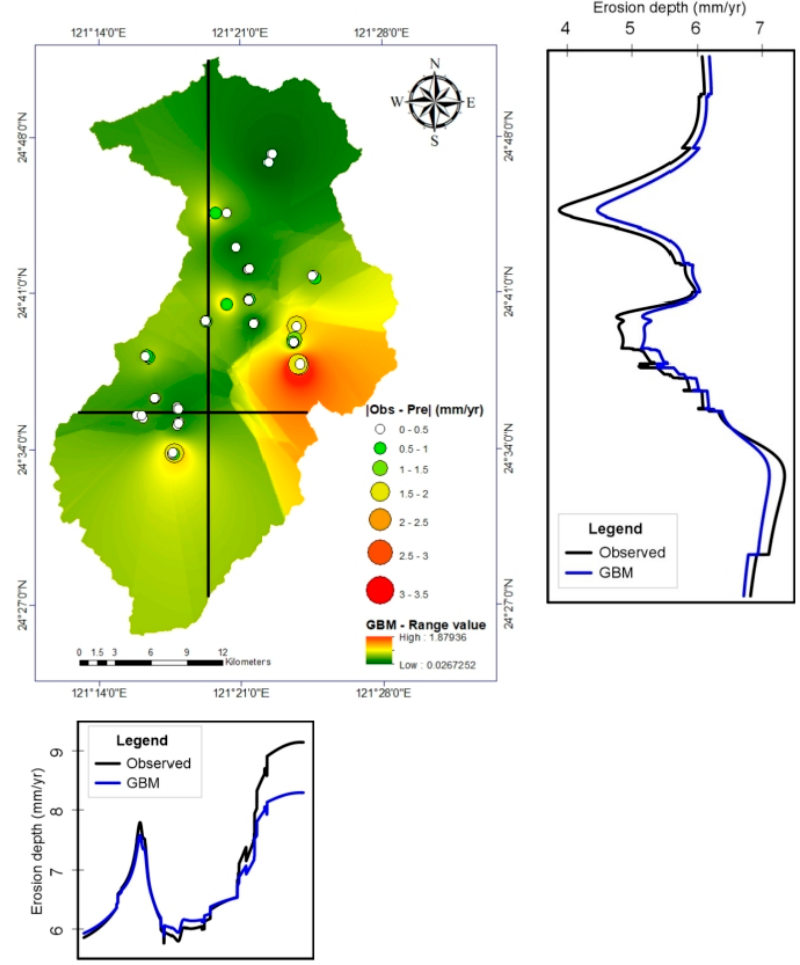
Figure 8. Map and profile of the study area showing the absolute difference between model prediction (GBM) and observation (mm/year).